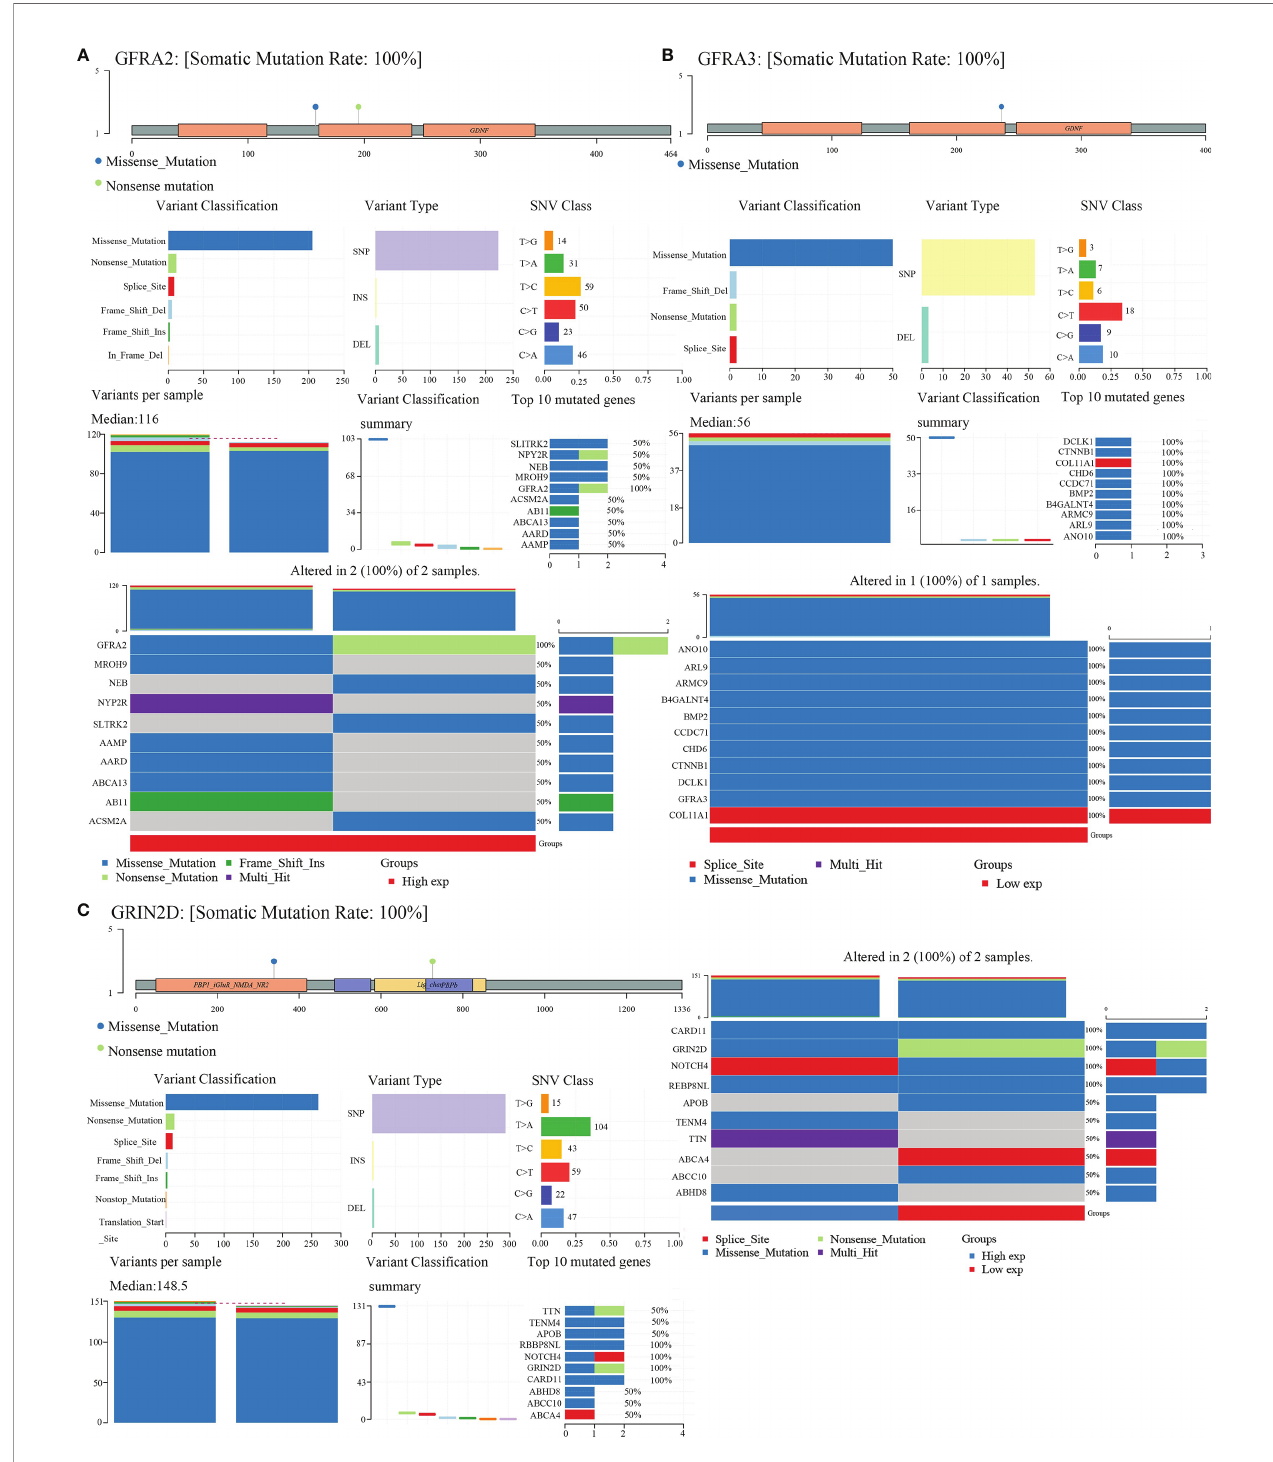
FIGURE 8 | Gene mutation landscape of GFRA2 , GFRA3 , and GRIN2D . (A) Gene mutation landscape of GFRA2 . A lollipop plot, an oncoplot, and cohort summary plot are shown to display the distribution of gene mutation. (B) Gene mutation landscape of GFRA3 . (C) Gene mutation landscape of GRIN2D